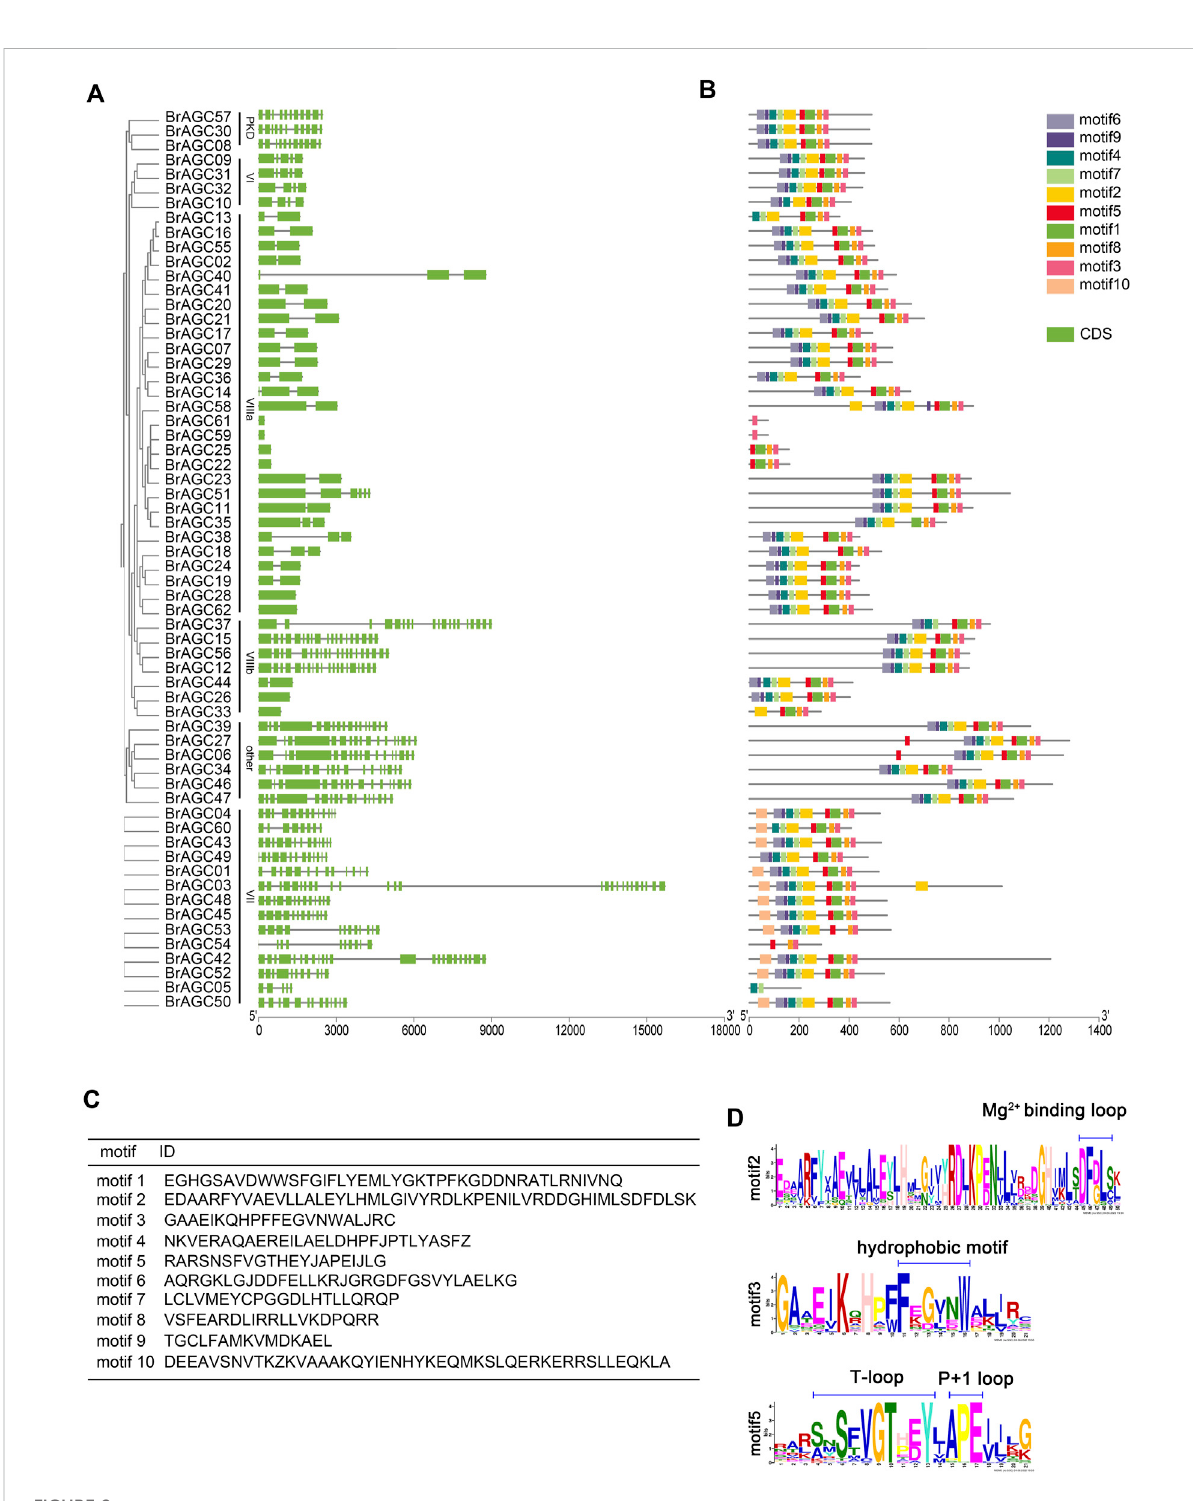
FIGURE 2 Gene structure and conserved motifs of BrAGC genes. (A) Composition and distribution of conserved motifs of BrAGC genes. (B) Exon – intron structureof BrAGC genes.Greenboxrepresentsexons, andlinesconnecting exonsareintrons. (C) Tenconservedmotifsequencesof BrAGC genes. (D) Motif logo of motif2, motif3, and